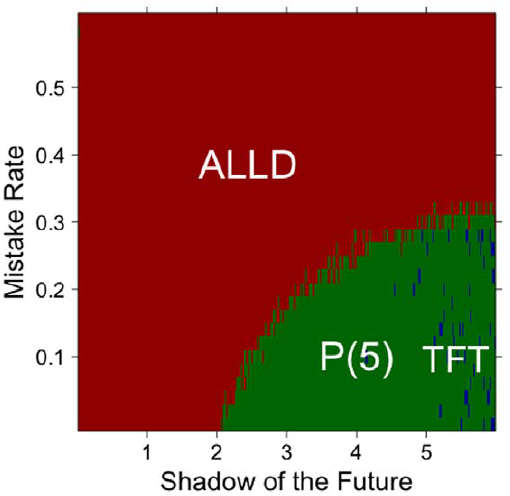
Figure 6. Strategies with the highest average score, as a function of the rate of mistake. The rate of mistake refers to the probability that a player will play randomly instead of following its strategy. The higher the mistake rate, the more the population plays cooperate or defect at random. Prejudiced strategies perform well for low levels of mistake and intermediate values of the shadow of the future. When more randomness is added, however, inferences drawn by prejudiced strategies become less and less reliable. The results are based on one hundred simulations with 50% TFT, 50% ALLD and one prejudiced